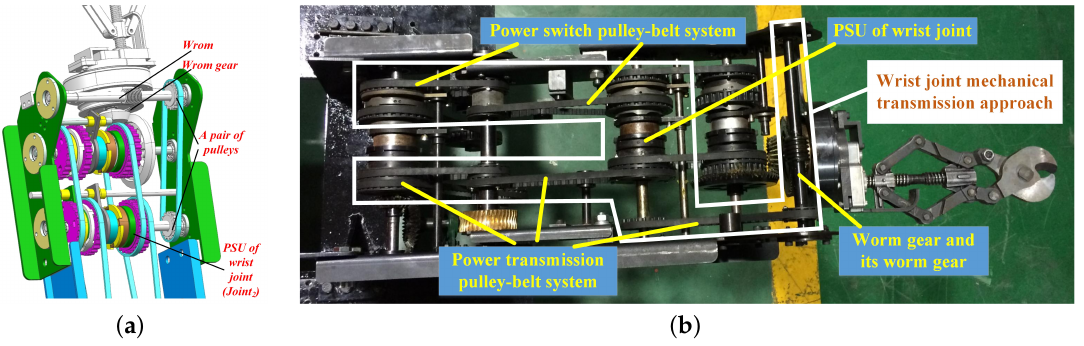
Figure 20. Illustration of the scissors joint. The scissors joint (in Joint 3 ) is assembled on the worm gear which is driven by the worm. The power is transmitted from the transmission shaft (Part 1, driven by the power motor) of the PSU to the worm by a pair of pulleys. ( a ) The 3D model of wrist joint. ( b ) The prototype of wrist joint.